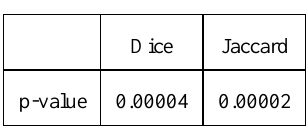
Table 3: Paired t-test results for final model (500 epochs) The Jaccard scores obtained for the RGB images were significantly higher (p < 0.001) than the scores obtained for the grayscale images. Similar results were obtained for the dice